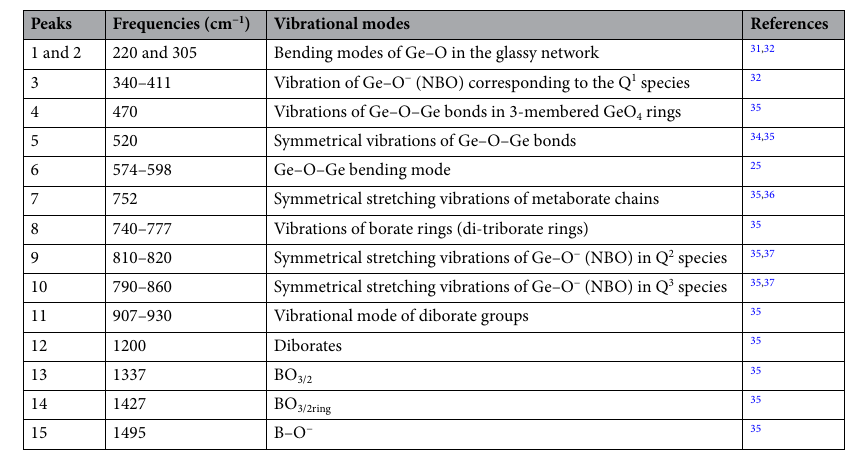
Table 2. Assignments of the main vibrational modes for the BGB- x Tb